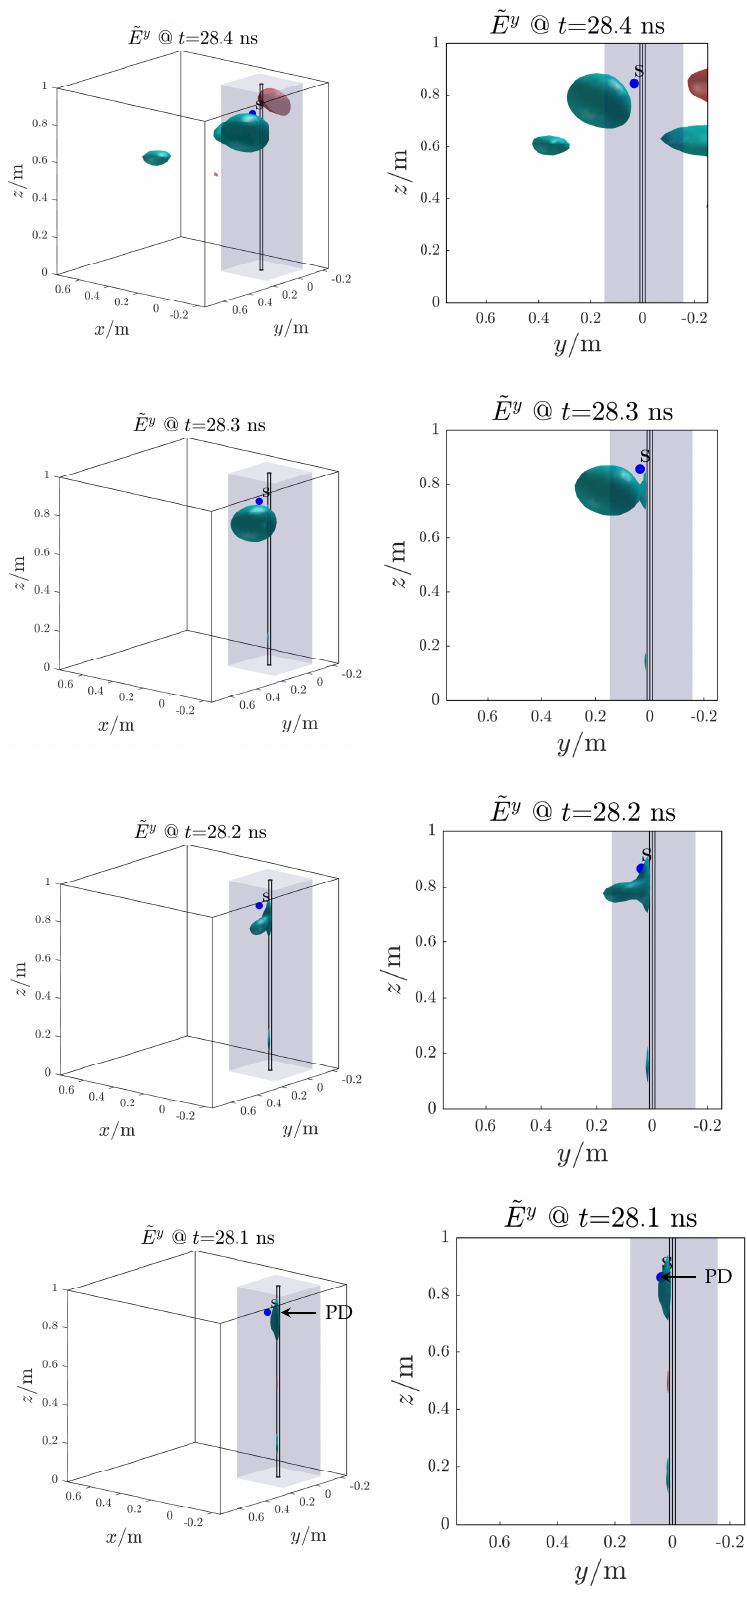
Figure 14. Test case 1. Reconstructed electric field distribution (propagation backward in time). The Partial Discharge (PD) source ( s , blue dot) is correctly localized. The volume around the cable is blue